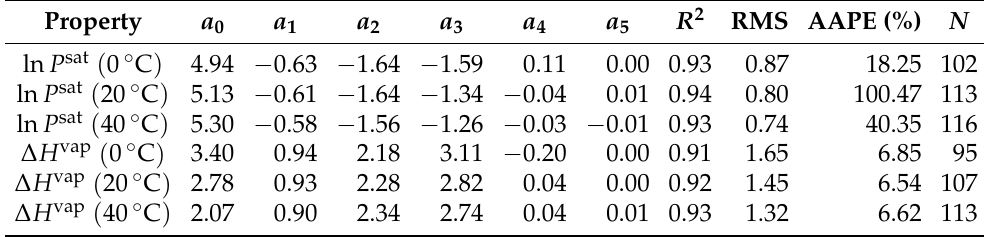
Table 2. Summary of the regressed model parameters using Equations (14) and (17) along with the Pearson correlation coefficient ( R 2 ), the root-mean-squared error (RMS), and the average absolute percent error (AAPE) to assess the goodness of fit, where N corresponds to the number of organic compounds included in the fit. In the correlations, P sat is in units of bar, and ∆ H vap corresponds to ∆ H vap / ( RT ) , which is dimensionless. The temperature indicates the temperature at which the regression was performed.